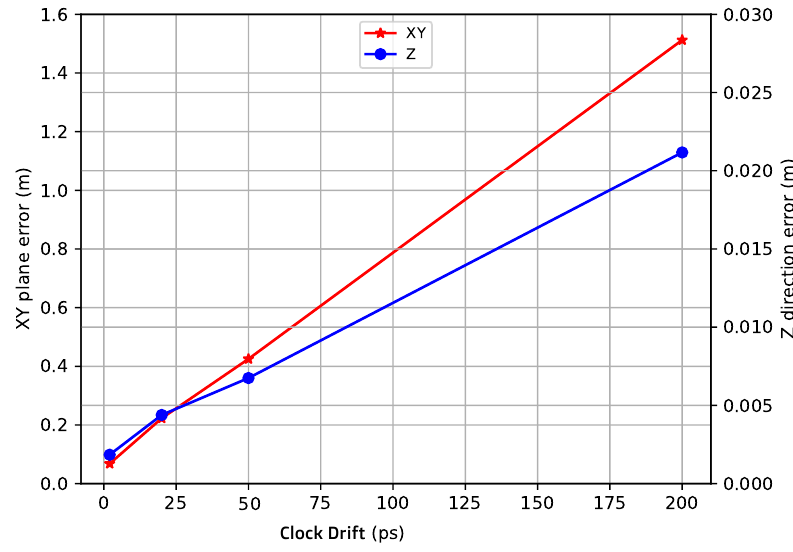
Figure 4. Localization error with respect to clock drifts. Figure 5 shows the localization error as a function of the sampling duration. As the sampling duration increases, the accuracy of the time of arrival estimate increases as per Equations (21) and (35). Accordingly, the accuracy of the estimates of the location coordinates increases as confirmed by Figure